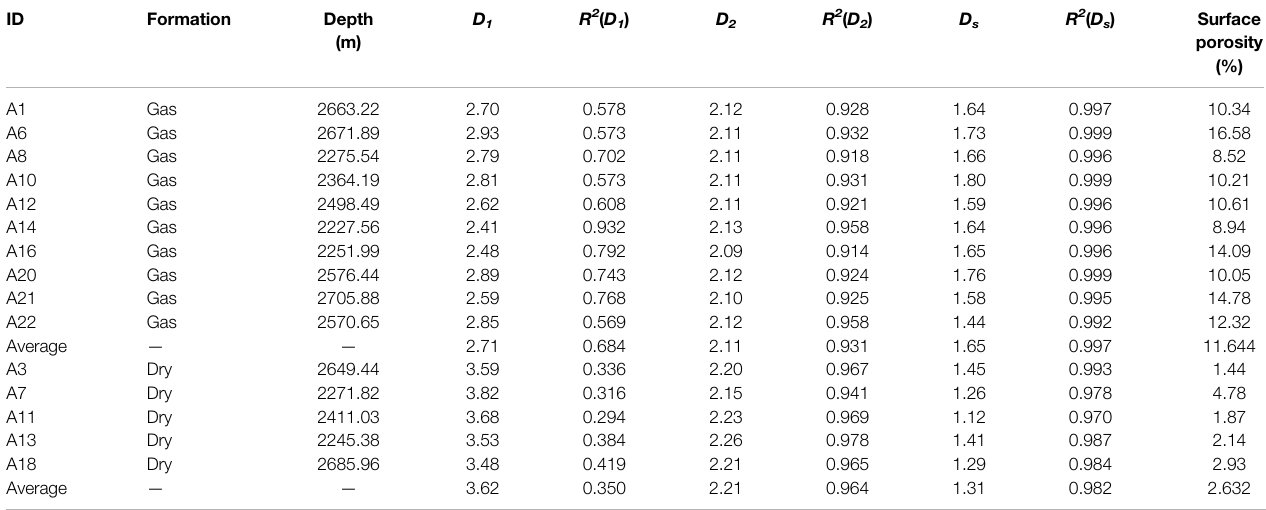
TABLE 3 | Parameters obtained from 2D Fractal analysis.